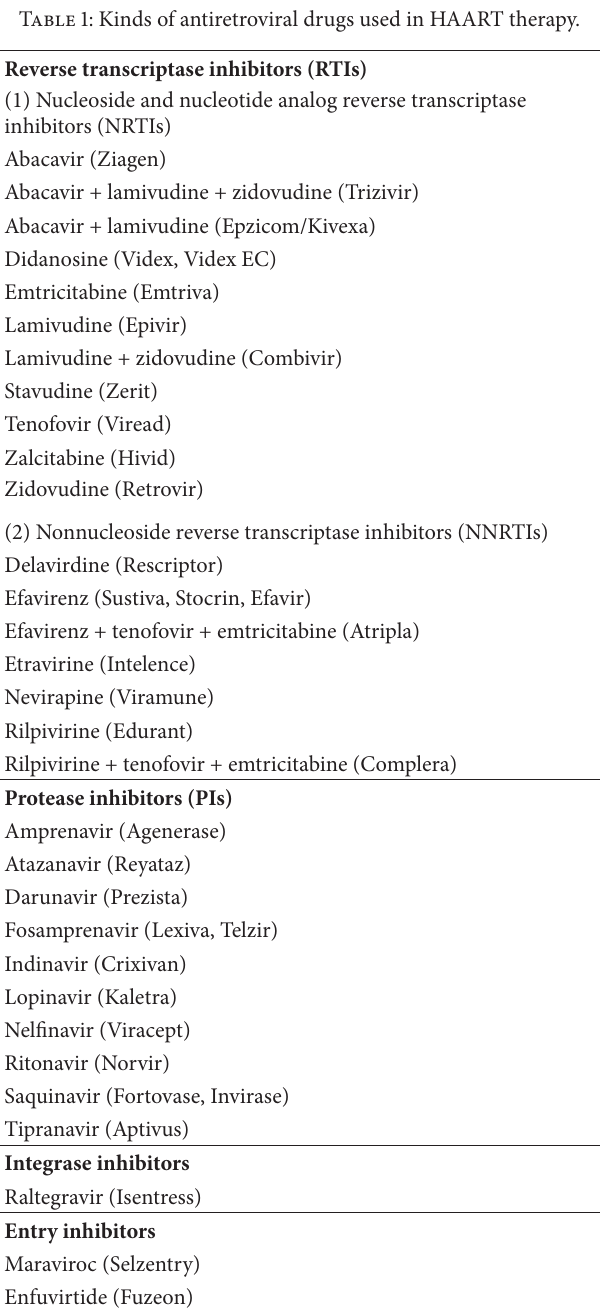
Table 1: Kinds of antiretroviral drugs used in HAART therapy. Reverse transcriptase inhibitors